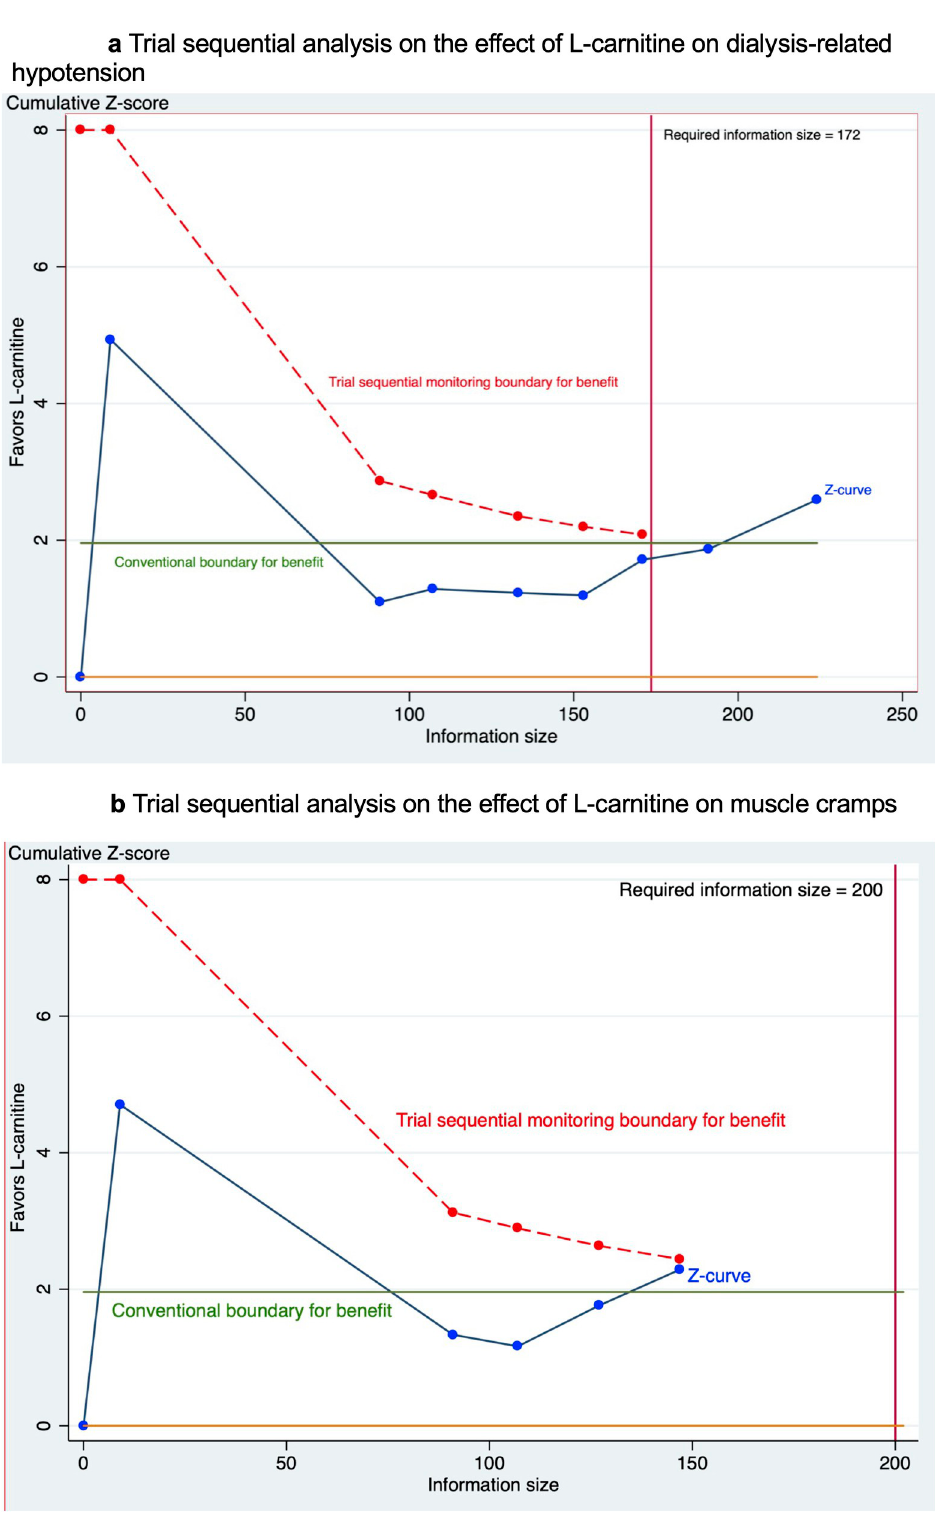
Fig 3. a. Trial sequential analysis on the effect of L-carnitine on dialysis-related hypotension. b. Trial sequential analysis on the effect of L-carnitine on muscle cramps.